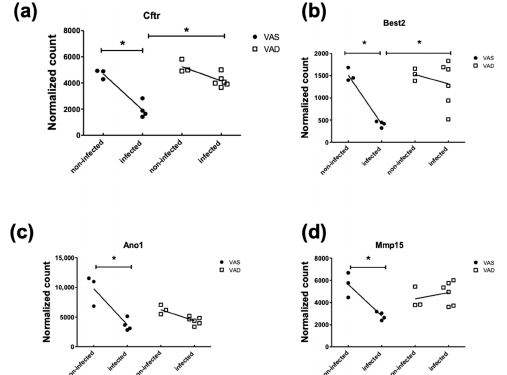
Figure 4. Representative DEGs corresponding to Scenario 2 in the colon. Expression of genes ( a ) cystic fibrosis transmembrane conductance regulator (Cftr), ( b ) Bestrophin ‐ 2 (Best2), ( c ) anoctamin 1 calcium activated chloride channel (Ano1), and ( d ) Matrix metalloproteinase 15 (Mmp15) in all four conditions. Note: * in the differential expression analysis, |FoldChange| > 2 and adjusted p ‐ value < 0.05. For a full list of the genes corresponding to Scenario 2 of the interaction effect, see Scenario 2 in the supplementary Excel file. Abbreviations : differentially expressed gene (DEG), vit ‐ amin A ‐ sufficient (VAS), vitamin A ‐ deficient (VAD).